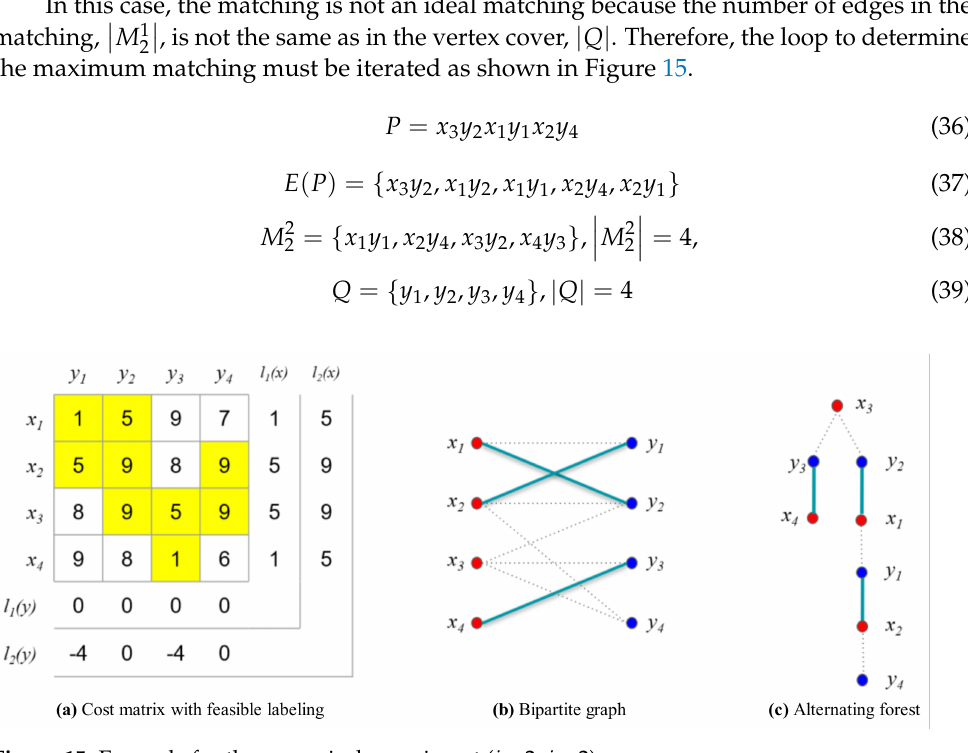
Figure 15. Example for the numerical experiment ( i = 2, j = 2).